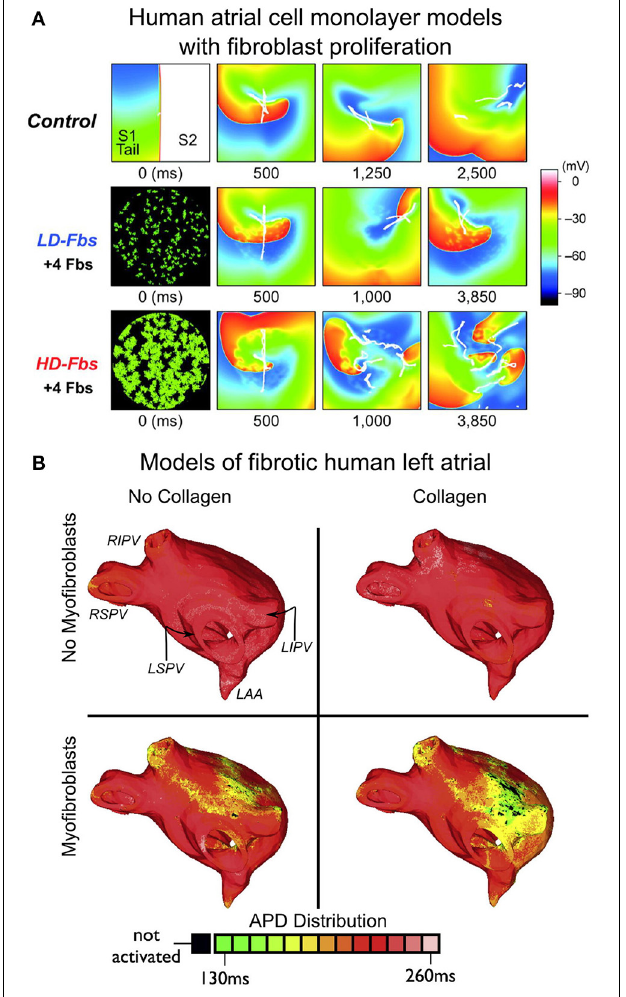
FIGURE 4 | Modeling fibroblast proliferation in the regions of fibrosis. (A) Effect of myocyte-fibroblast coupling (modeled as in Maleckar et al., 2009a) on spiral wave behavior in a human atrial cell monolayer model of size 4.5 × 4.5cm. Top, control case without fibroblasts. Middle and bottom, models of low-density and high-density fibroblast proliferation (LD-Fbs and HD-Fbs) in a central circular region of the sheet. In the LD-Fbs, and HD-Fbs models, atrial myocytes (100pF), each connecting to 4 fibroblasts (6.3pF) within the Fb-Area, account for 12.5% and 50.0% of that area, respectively. With permission from Ashihara et al. (2012). (B) Maps of action potential duration (APD) in four human atrial models (same atrial geometry). Fibrotic lesions are modeled with (bottom row), and without (top row) myofibroblast infiltration (and coupling to myocytes), as well as with (right column), and without (left column) diffuse collagen deposition for both sets of maps. Myofibroblasts in the fibrotic regions were coupled to atrial myocytes as described in Maleckar et al. (2009a) and Maleckar et al. (2009b). Anatomical landmarks in upper-left sub-panel: right inferior, right superior, left inferior, and left superior pulmonary veins (RIPV, RSPV, LIPV, LSPV, respectively); left atrial appendage (LAA). With permission from McDowell et al. (2013).